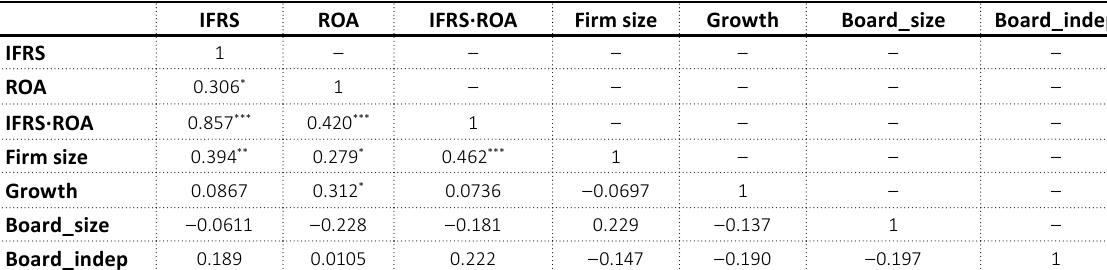
Table 2. Correlation matrix